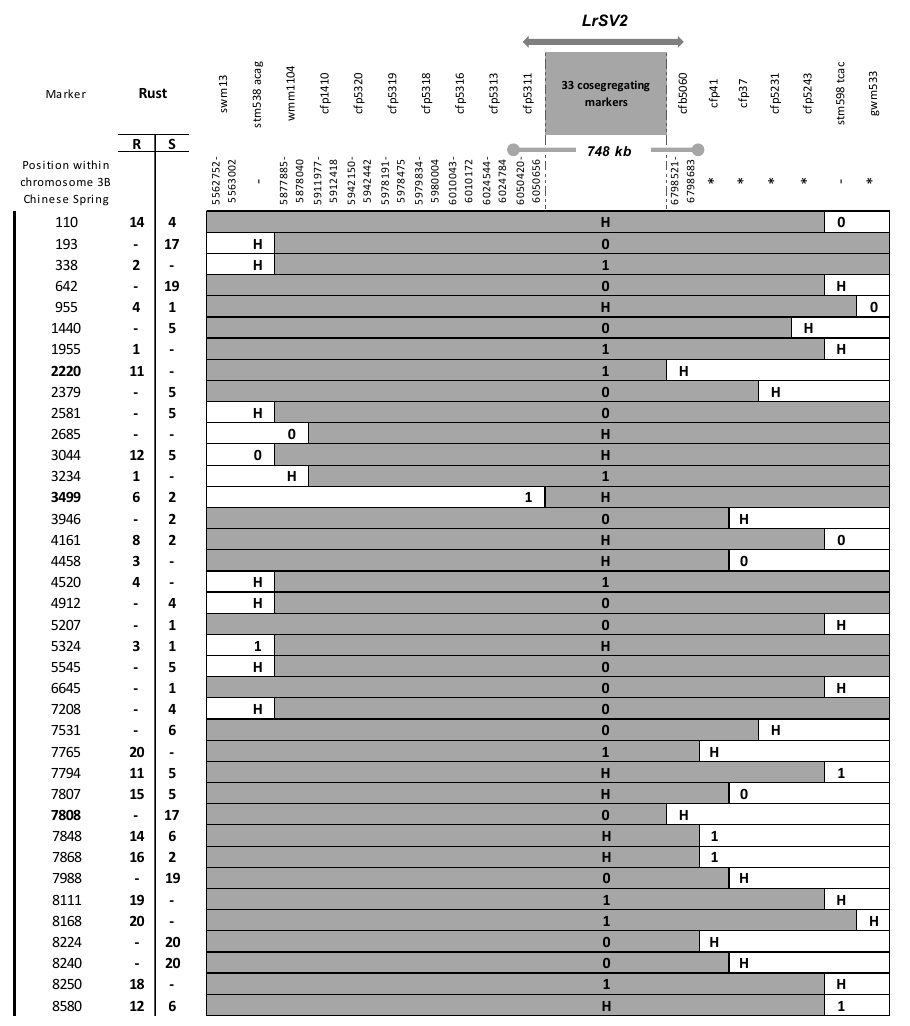
Figure 3. Graphical genotype table of the 38 critical recombinant F2s found between swm13 and gwm533 markers. Markers positions on the Chinese Spring chromosome 3B IWGSC RefSeq v2.1 is shown. * No blast on this 3B pseudomolecule, ordered according to conting344 [60]. Recombinants for the minimal interval containing the LrcSV2 gene are depicted in bold. 0 susceptible Gama6 genotype, 1 resistant Sinvalocho genotype, H heterozygote genotype. Rust: F3 artificial infection (F4 for recombinant 642) with P. triticina race Ca02G1R at adult stage, R resistant phenotype, S susceptible phenotype. Cosegregating markers are described in Supplementary Table S1.